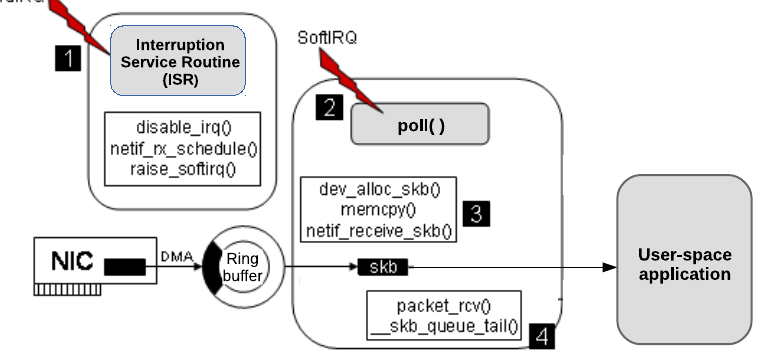
Figure 1. Linux packet-capture